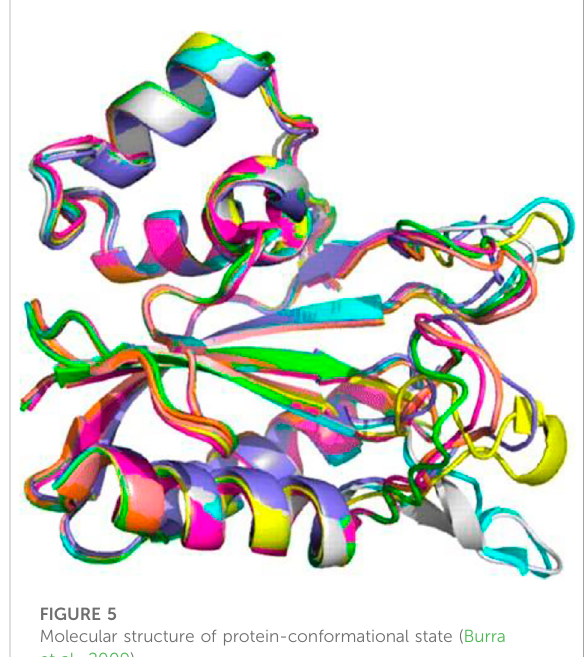
Molecular structure of protein-conformational state (Burra et al.,